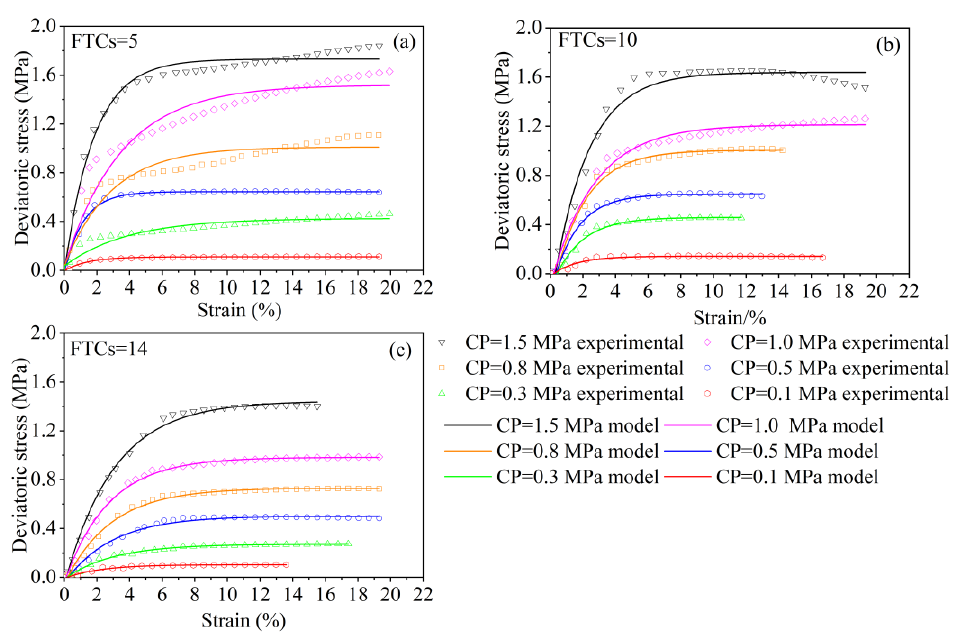
Figure 9. Theoretical stress–strain curves for calculated and tested values of solidified soils.